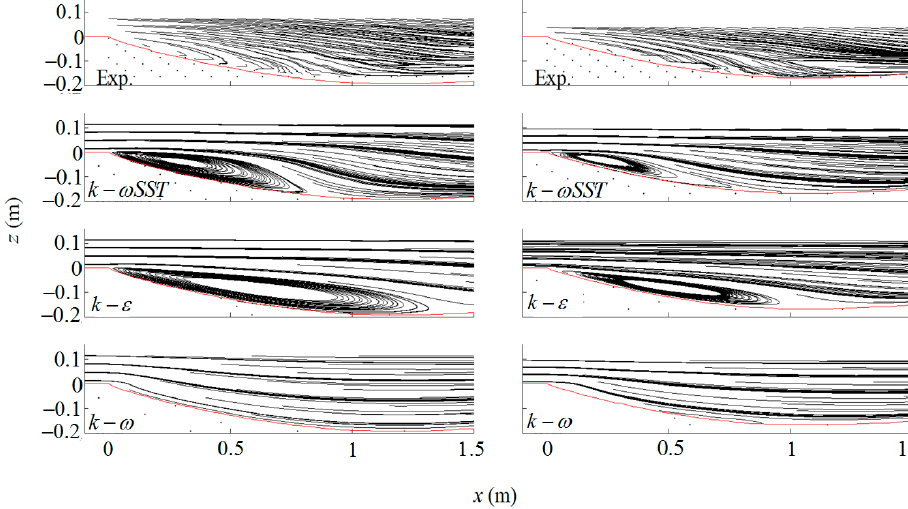
Figure 4. Numerical flow streamline of different turbulence models along with the experimental data for Case Exp1 ( left ) and Case Exp2 ( right ). The red lines represent the channel bed.